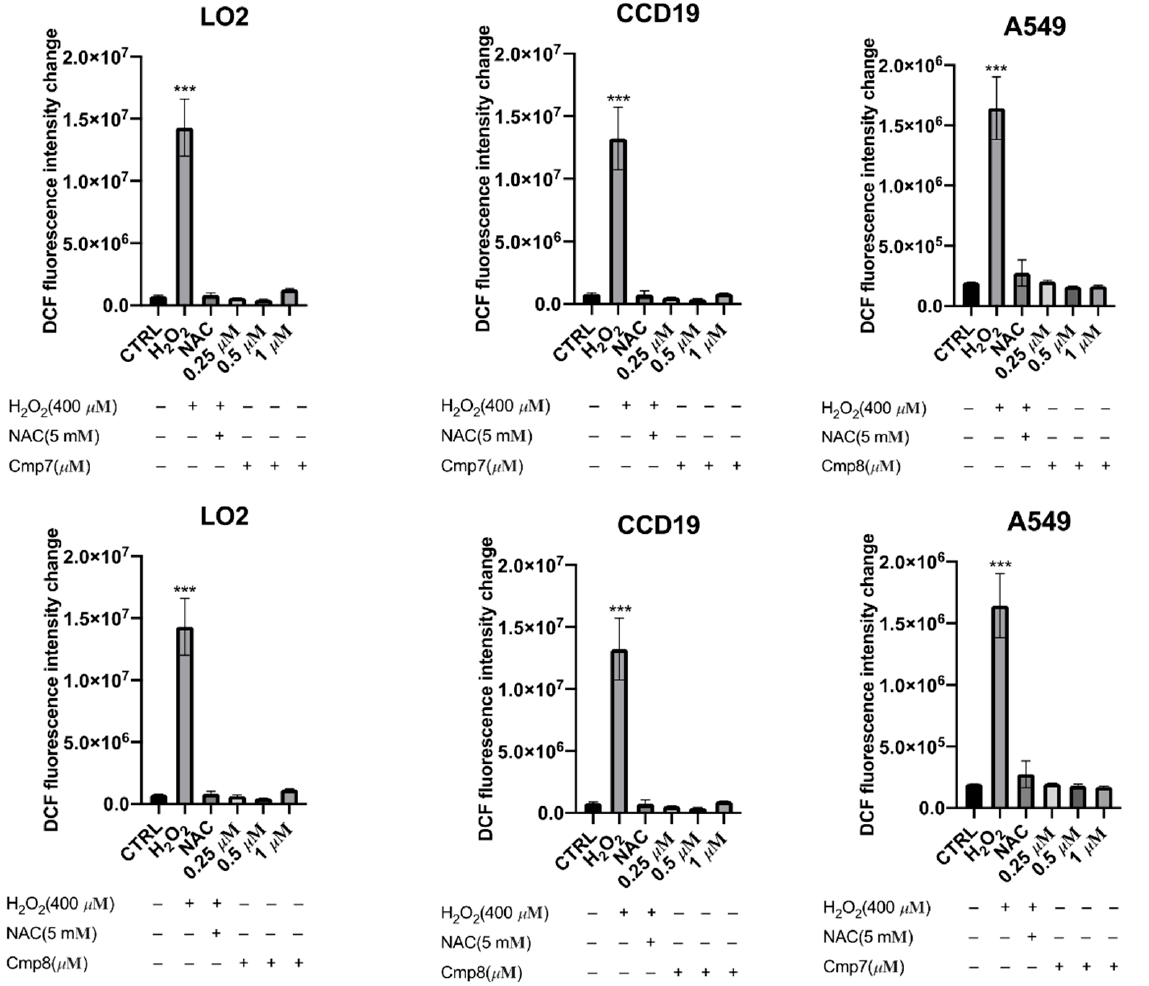
Figure 4. ROS generation for compounds 7 and 8 in cancer cells (A549) compared to normal cells (CCD-19Lu and LO2). Intracellular ROS generation was quantified by using DCF dye and measured by the relevant fluorescent signal. By t -test analysis, *** p < 0.001 , comparing to the control group.